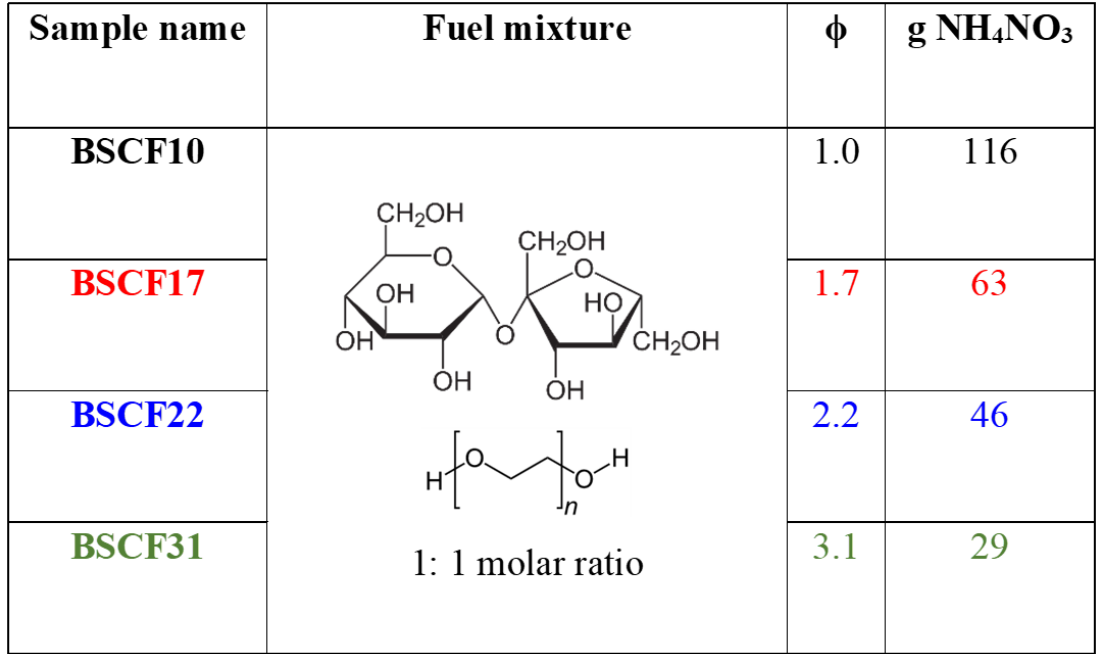
Figure 9. Sample names, type of fuel mixture, corresponding Φ values and mass (grams) of ammonium nitrate used as additional oxidant to regulate the Φ ratio for the synthesis of 3 g of perovskite powder. Other synthesis conditions were maintained constant (m sucrose = 18.774 g, m PEG 20000 = 2.416 g, m Ba(NO3)2 = 1.792 g; m Sr(NO3)2 = 1.451 g, m Co(NO3)2 · 6H2O = 3.192 g, m Fe(NO3)3 · 9H2O = 1.108 g).